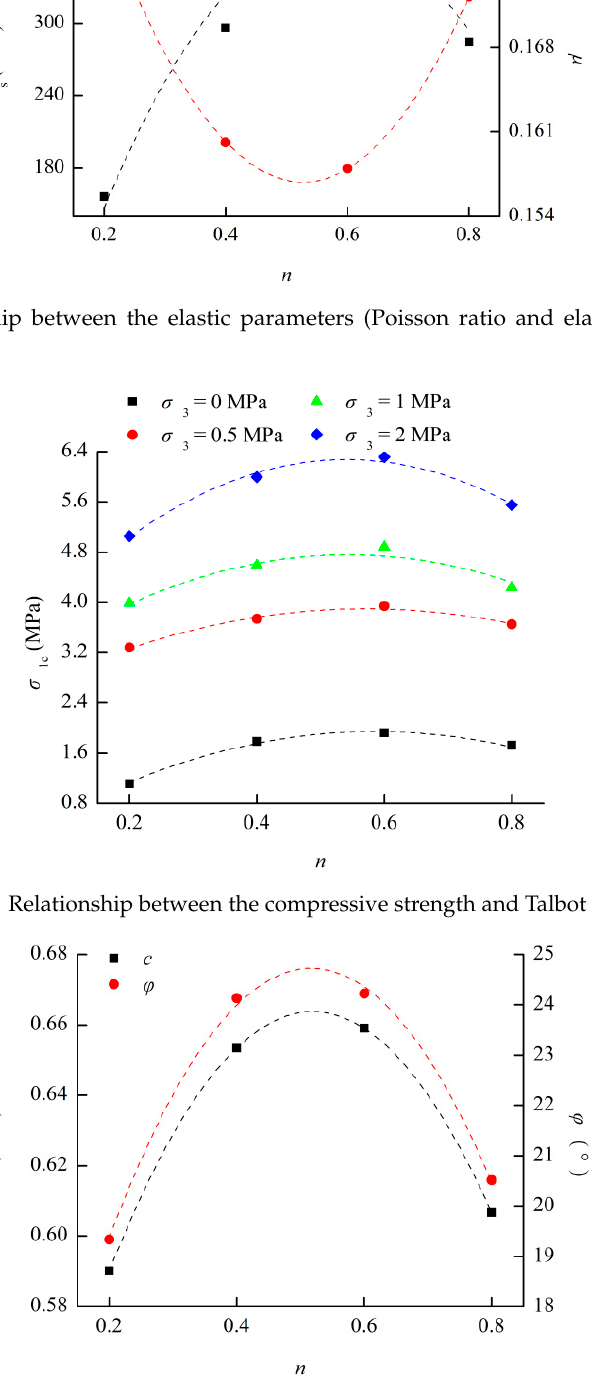
Figure 6. Relation between the Mohr-Coulomb strength parameters (cohesive force and internal friction angle) and the Talbot index.